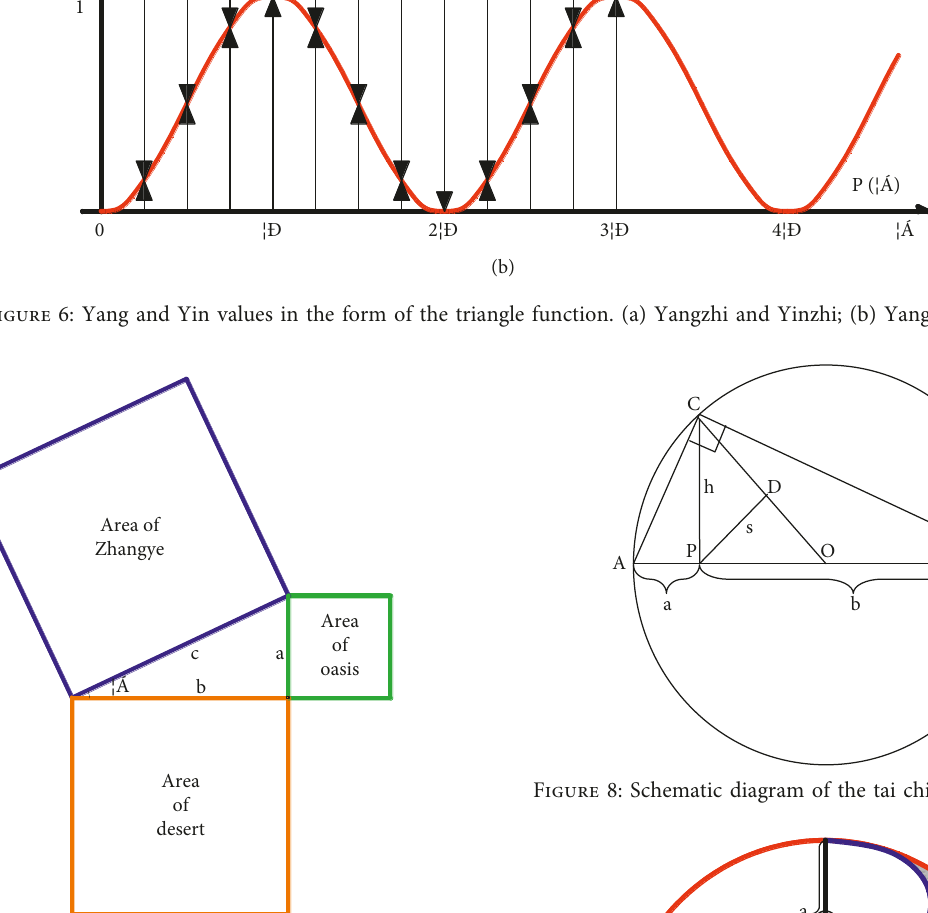
Figure 7: Area relationship diagram of Zhangye Oasis Desert.